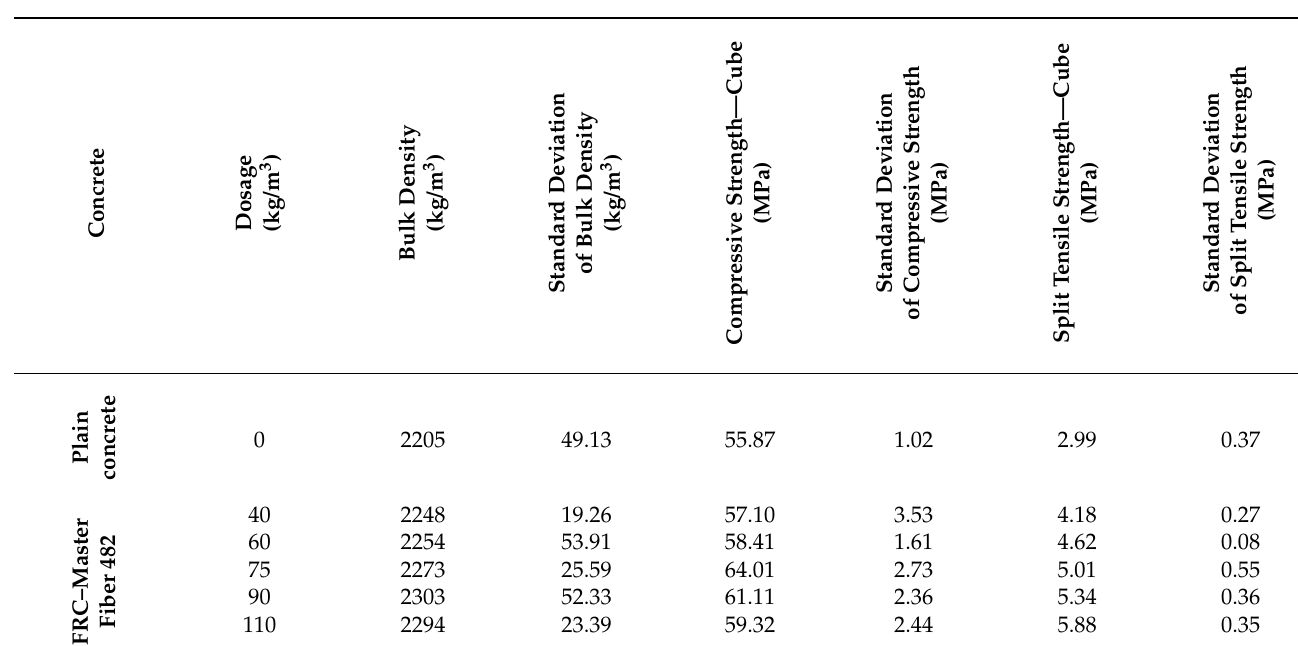
Table 3. Results of the testing of basic mechanical properties.